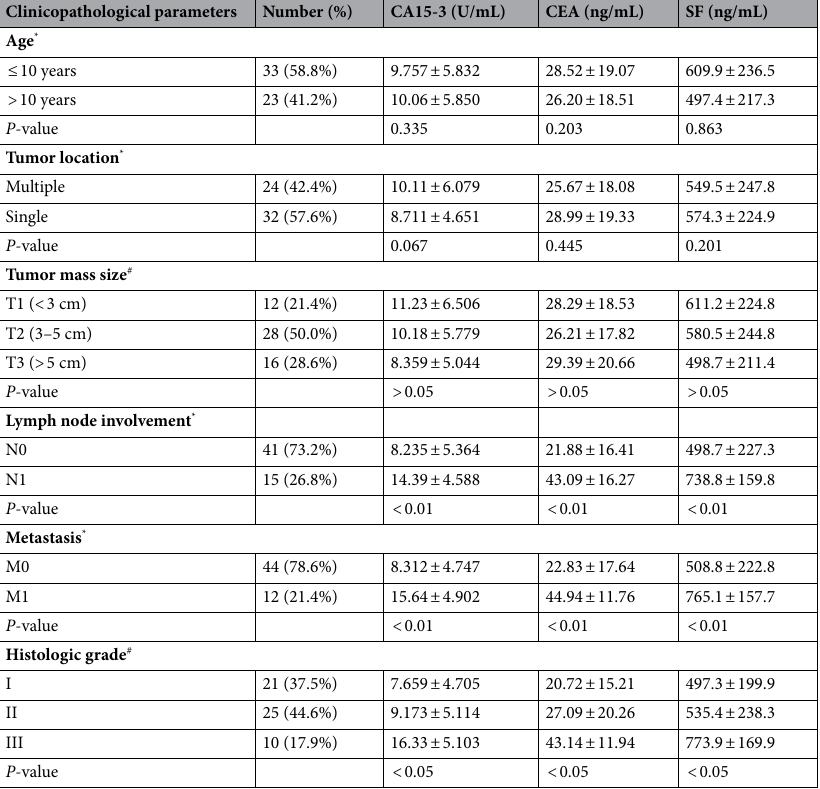
Table 2. Correlation between serum CA15-3, CEA and SF in canine mammary gland tumor and clinicopathological parameters. * Unpaired t test; # one ANOVA test; P < 0.05 show significant difference; P < 0.01 show extremely significant difference.